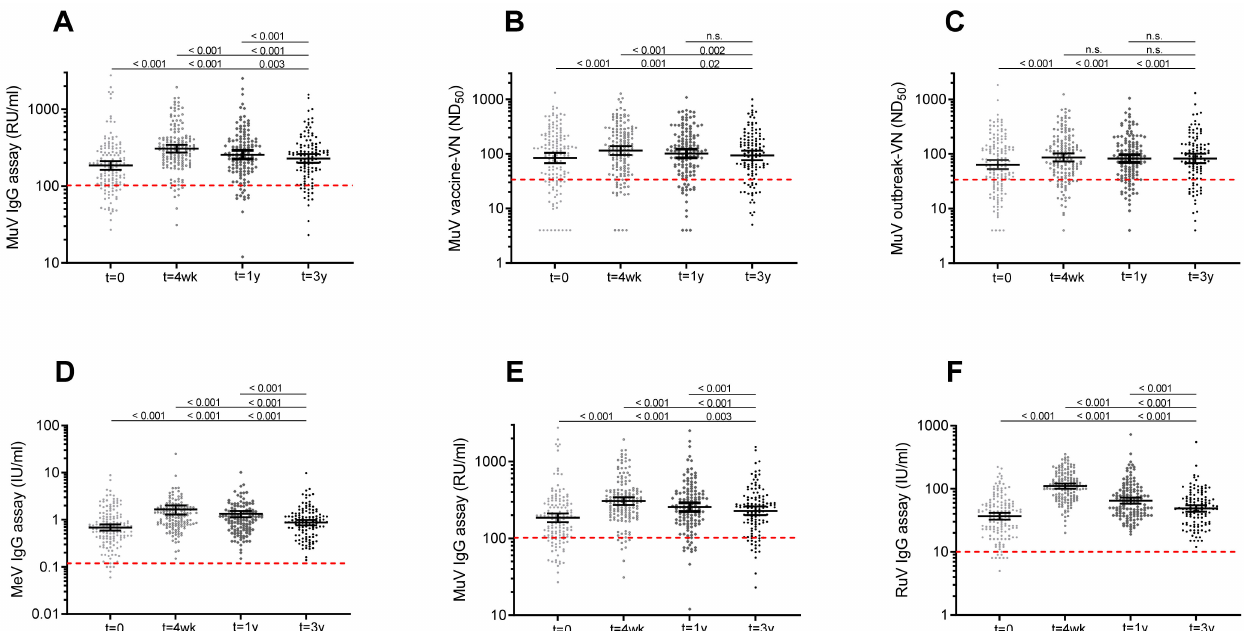
Figure 3. Scatterplot showing IgG and virus neutralizing antibody levels to mumps virus and concentrations of IgG antibodies against rubella and measles virus prior to and after a third measles- mumps-rubella vaccine dose. MuV-IgG concentrations ( A ), ND50 titers against MuV vaccine strain ( B ), and ND50 titers against MuV outbreak strains ( C ) prior to, and 4 weeks, 1 year and 3 years following an MMR3 dose. Concentrations of IgG antibodies against measles ( D ), mumps ( E ), and rubella ( F ) virus prior to, and 4 weeks, 1 year and 3 years after an MMR3 dose. Geometric mean IgG concentrations and ND50 titers, with 95% confidence interval are indicated as horizontal bars. Red dashed line indicate the surrogate antibody cutoff level for protection. Differences in antibody levels between time points were analyzed with Wilcoxon signed-rank test. Observed significant differences were in line with the results of the model fit. P-values related to comparisons to the pre-vaccination antibody levels are listed at the bottom, above are the P-values related to comparisons to the antibody levels at 4 weeks, and at top, the P-value for comparison of antibody levels at 1 year and 3 years after MMR3. Abbreviations: MuV IgG, mumps virus-specific IgG concentration; RU/mL, RIVM units per milliliter; MuV vaccine-VN, virus neutralizing antibodies against Jeryl Lynn (JL) mumps vaccine strain; ND50, virus-neutralizing antibody titer which resulted in 50% plaque reduction; MuV outbreak-VN, virus neutralizing antibodies against mumps outbreak strain; MeV IgG, measles virus-specific IgG concentration; U/mL, units per milliliter; RuV IgG, rubella virus-specific IgG concentration; t = 0, prior to a third dose of measles-mumps-rubella vaccine dose (MMR3); t = 4 wk, four weeks; t = 1 y, one year; t = 3 y, three years after